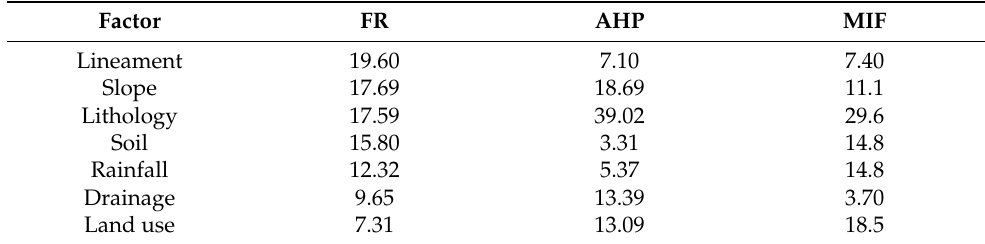
Table 9. Weightage assigned for each influential factor in three different models.